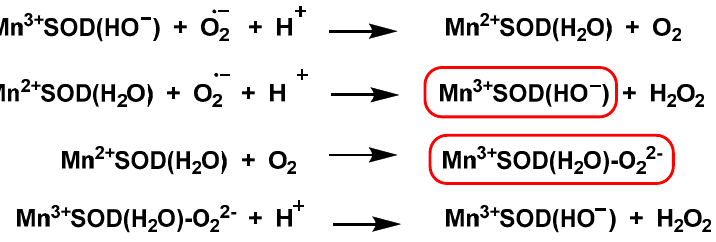
Figure 36. The mechanism includes the formation of both Mn 3+ SOD and the complex (Mn 3+ SOD(H 2 O)-O 22 − ).